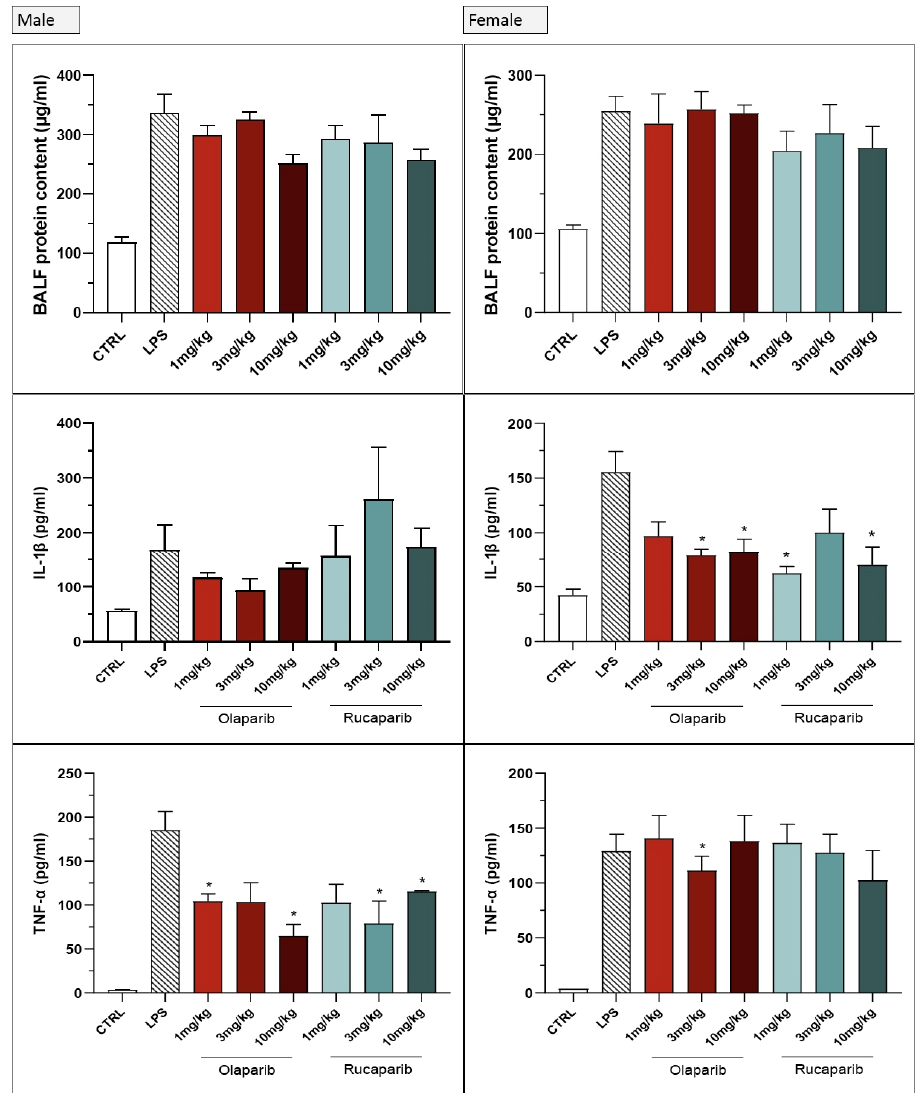
Figure 24. Lack of sex difference in the effect of PARP inhibitors in the LPS-induced ALI model in mice in the pre-treatment paradigm. C57Bl/6 mice received either PBS (30 µ L) or LPS (50 µ g in 30 µ L PBS) by intratracheal instillation in the absence or presence of various doses (1, 3, or 10 mg/kg) of olaparib or rucaparib pre-treatment. After 24 h, bronchoalveolar lavage fluid was collected, and protein content, TNF α , and IL-1 β levels were measured. * p < 0.05 indicates inhibitory effects of the PARP inhibitors tested in LPS-treated animals. Data are shown as mean ± SEM, n = 4–6/group. No significant sex differences were seen in olaparib’s effect in the post-treatment paradigm (Figure 25).